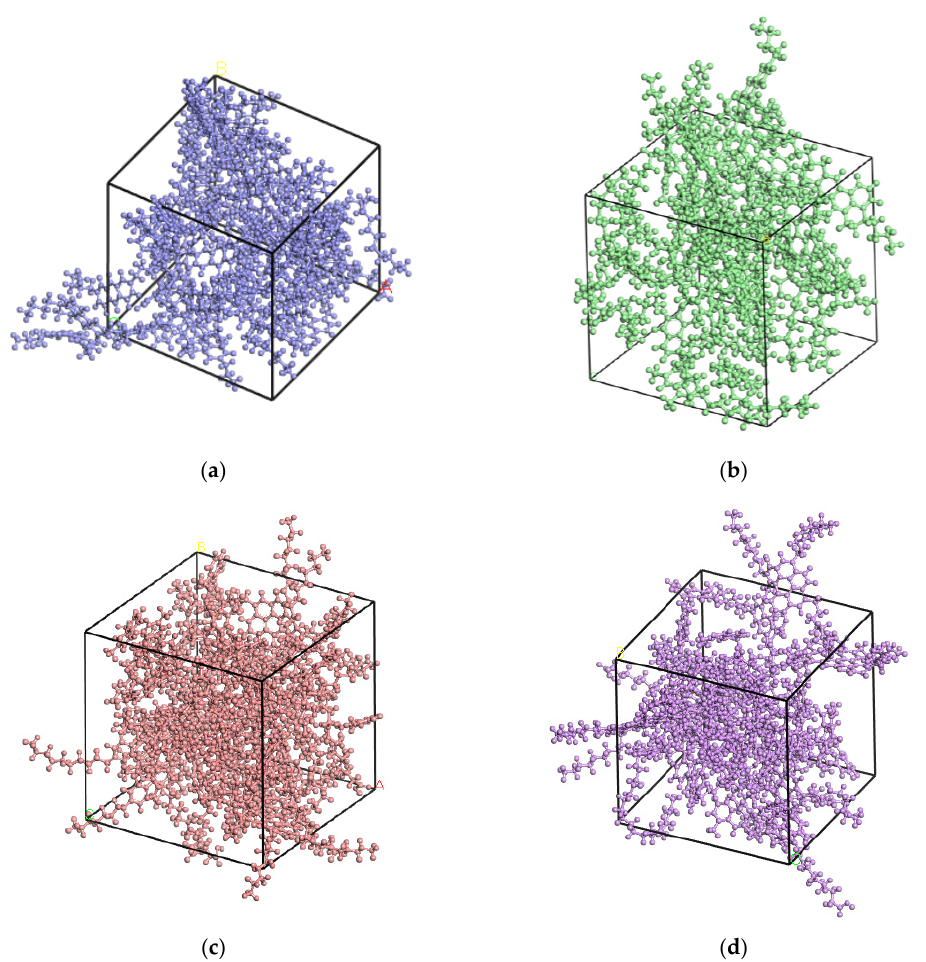
Figure 2. Two types of new asphalt and old asphalt models: ( a ) Panjin 90# asphalt; ( b ) aged Panjin 90# asphalt; ( c ) Zhonghaiyou 90# asphalt, and ( d ) aged Zhonghaiyou 90# asphalt.